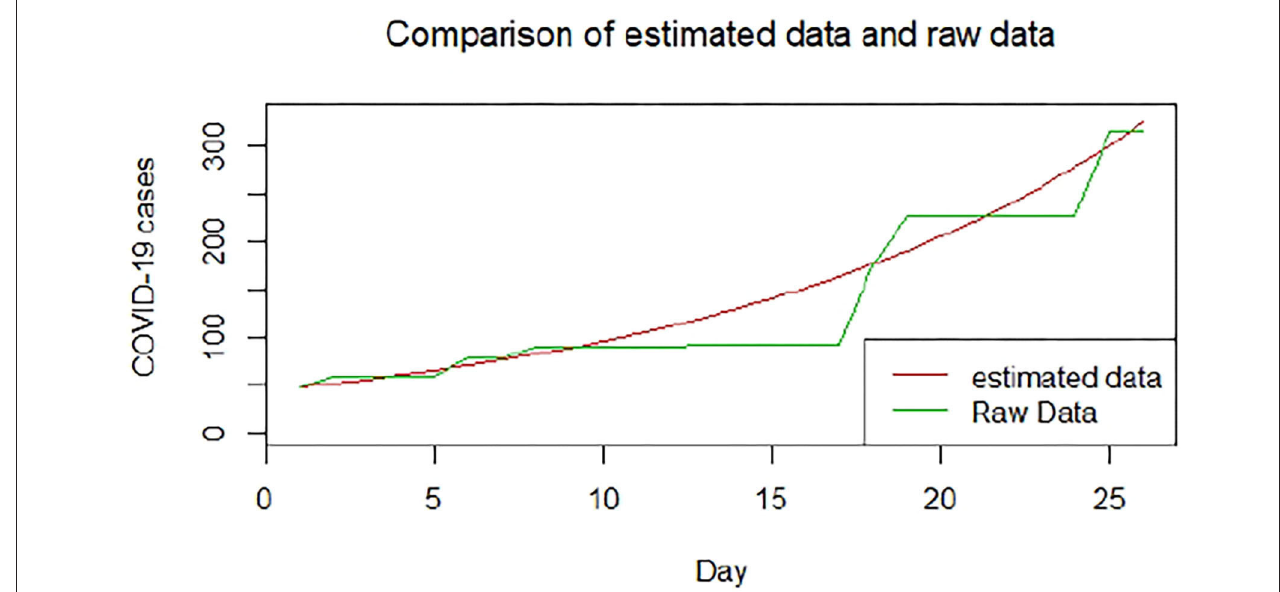
FIGURE 20 | Graph for Botswana.